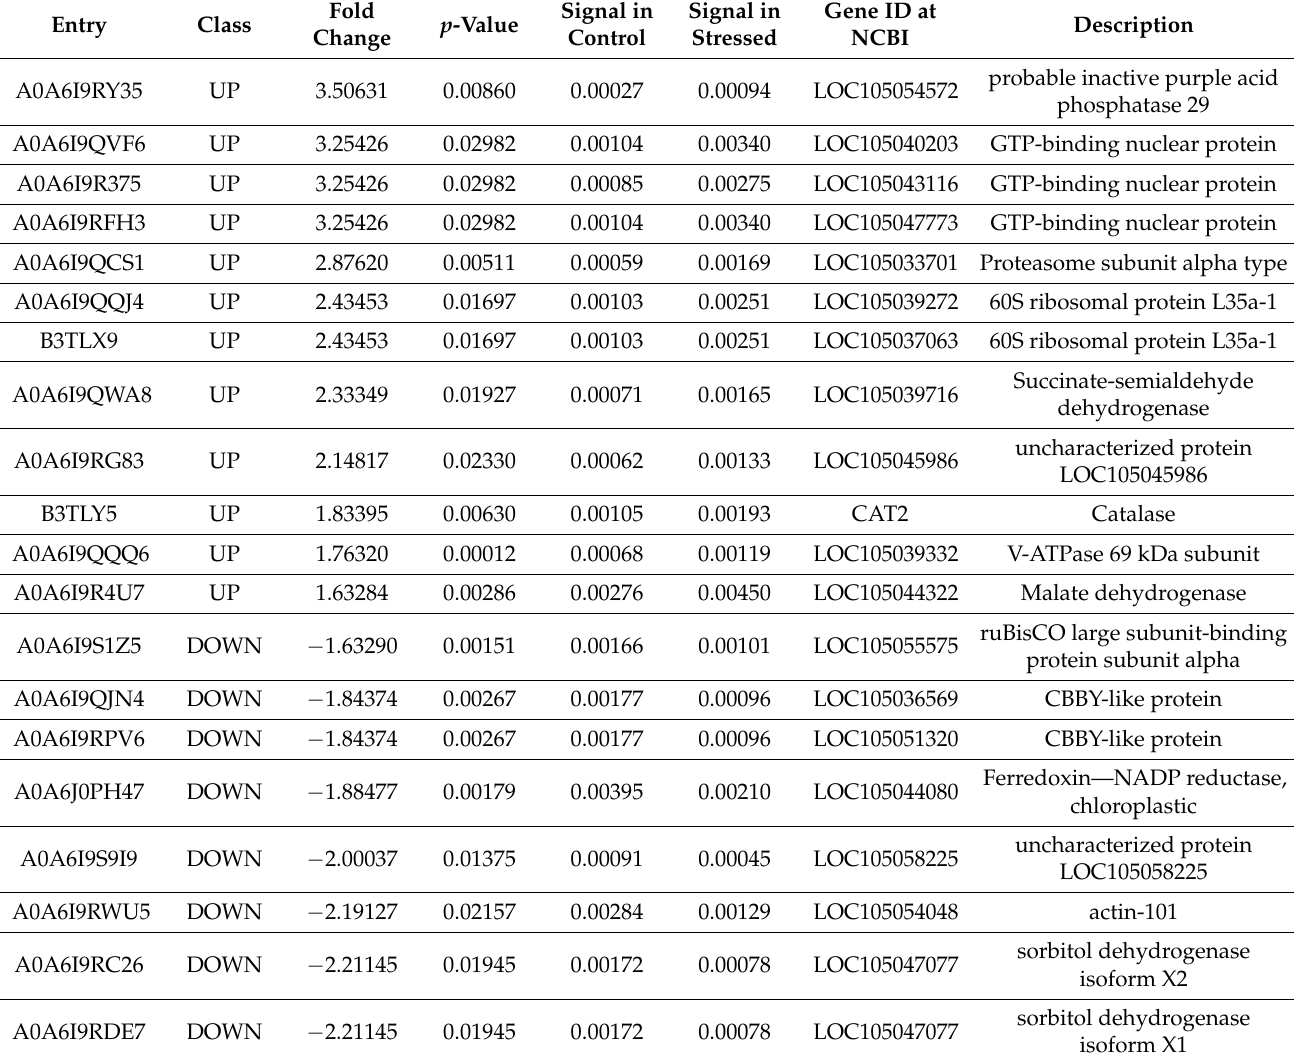
Table 3. List of the differentially expressed proteins detected in both biological conditions (Stressed and Control) with statistical significance (FDR ≤